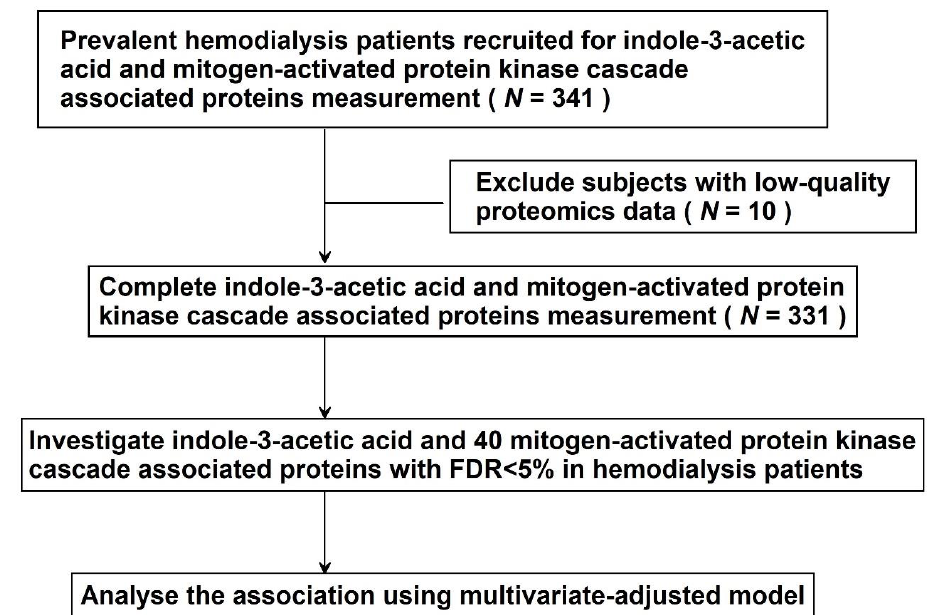
Figure 1. Study design. Table 1. Baseline characteristics of 331 hemodialysis